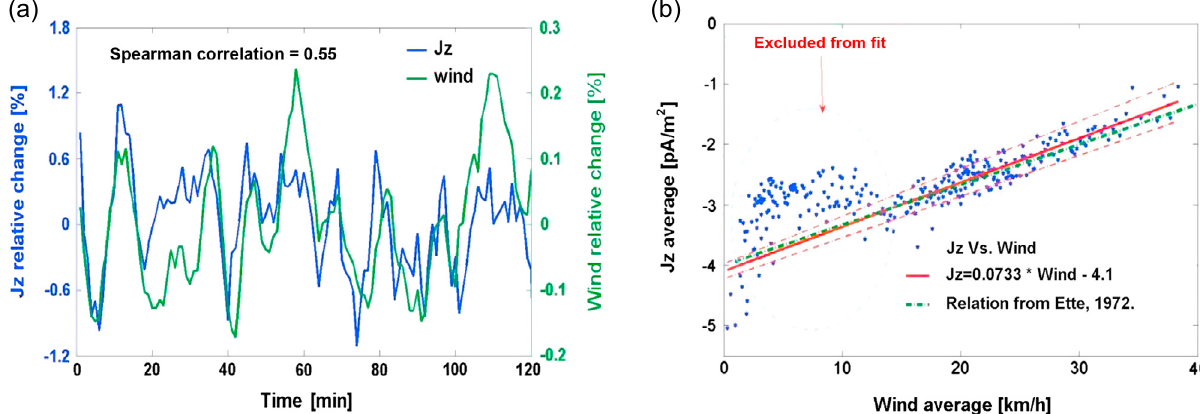
Figure A1. Correlation between wind speed and Jz. (a) Relative changes of J z and wind speed from 2 h of measurements taken on the 10 May 2011. (b) J z vs. wind speed. Blue dots – measured data; Red solid line – linear fit to measured data. Green line – Ette’s